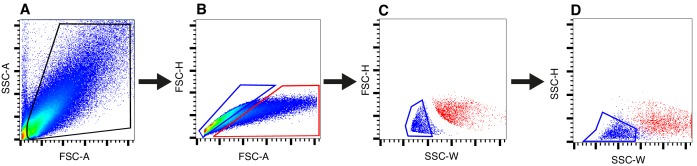
A typical workflow of sequential gating strategy for doublet exclusion is shown.(A) Scatter gate, FSC-A vs SSC-A, was plotted to exclude cell debris; the three subsequent ‘doublet discrimination’ gating strategies to exclude doublets are: (B) FSC-H vs FSC-A plot, (C) FSC-H vs FSC-W and (D) SSC-H vs SSC-W. Blue and red gates depict ‘single cell’ and ‘doublet’ events, respectively. Only the cells in the blue gates were sorted and/or analyzed. The scatter profiles of putative doublets (red dots) are also illustrated in panel (C) and (D).